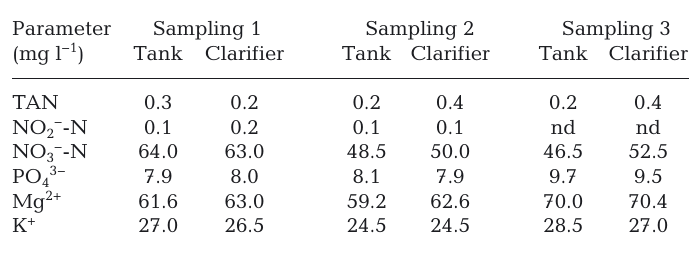
Table 4. Soluble nutrients (PO 43− , K + , total ammonia nitrogen [TAN], NO 3− -N, NO 2− -N, Mg 2+ ) measured at the inlet of a fish tank and the outlet of the clarifier of a tilapia recirculating aquaculture system. Data are the results of 3 successive samplings. nd: parameters not